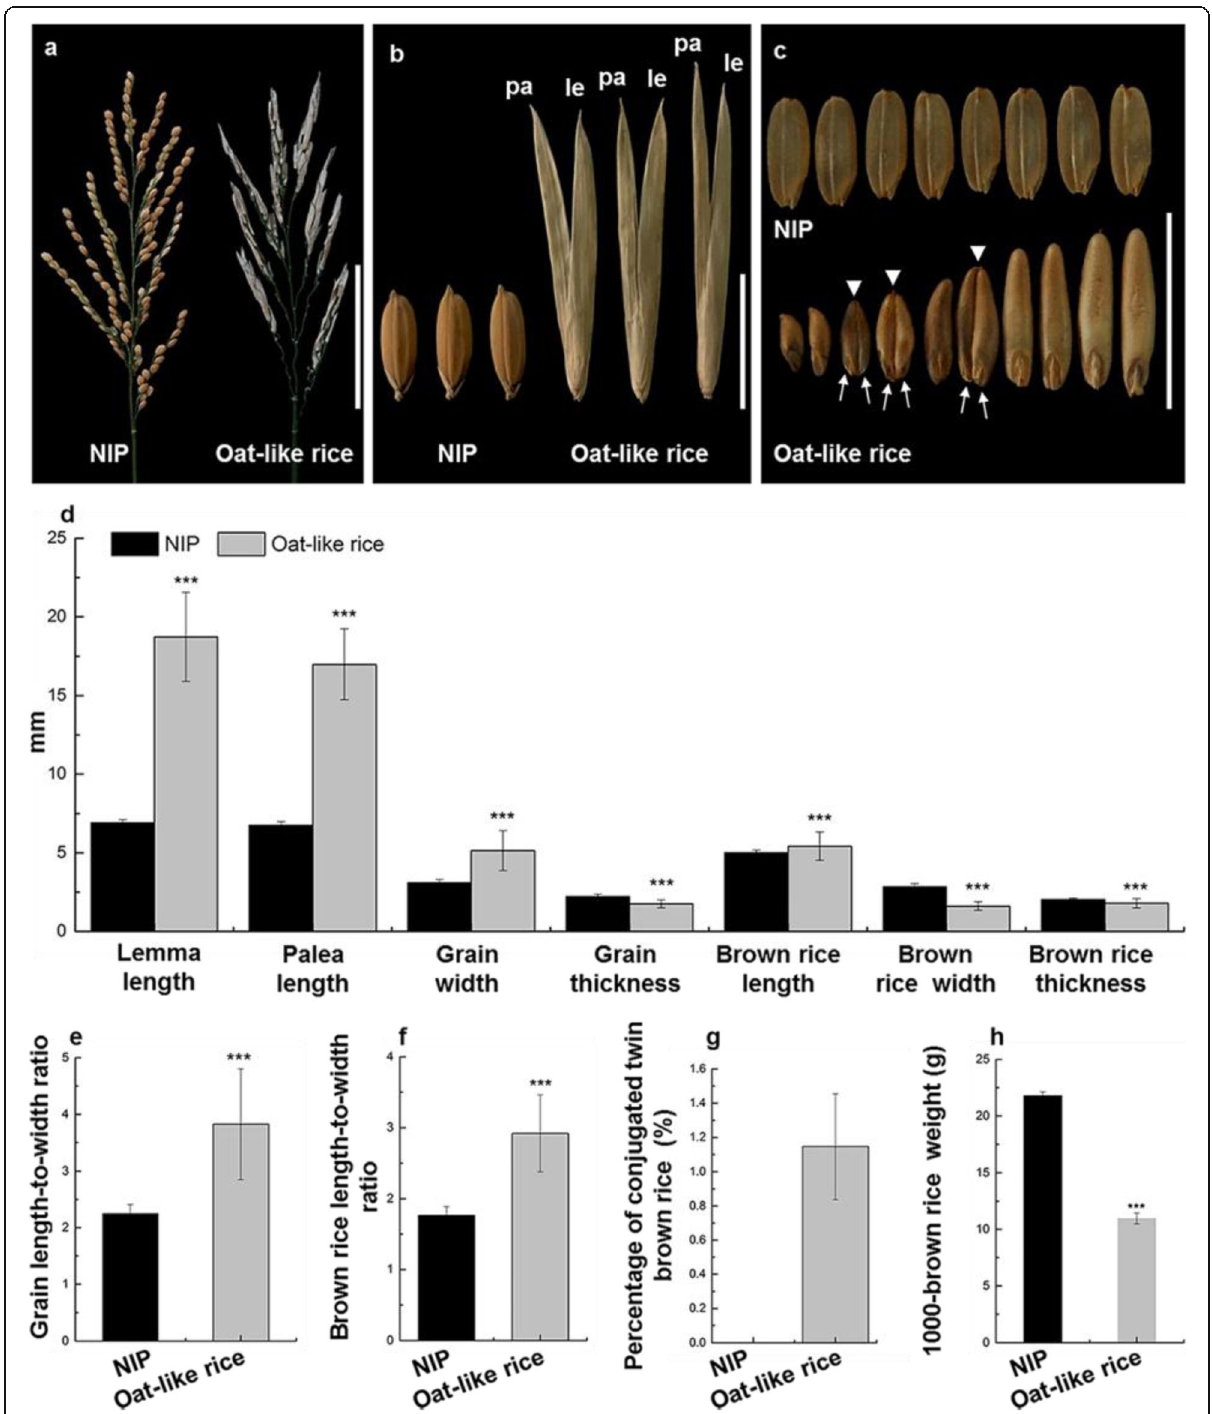
Fig. 1 Typical morphological characteristics of Oat-like rice . a Panicle morphology of NIP (left) and Oat-like rice (right). le, lemma; pa, palea. b Comparison of grain shape between NIP (left) and Oat-like rice (right). c Morphological comparison of brown rice between NIP (up) and Oat-like rice (down). Arrowheads indicate conjugated twin brown rice; arrows indicate two embryos of a conjugated twin brown rice grain. d Comparison of lemma length, palea length, grain width, grain thickness, brown rice length, brown rice width and brown rice thickness between NIP and Oat-like rice. e-h Comparison of grain length-to-width ratio ( e ), brown rice length-to-width ratio ( f ), percentage of conjugated twin brown rice ( g ) and 1000-brown rice weight ( h ), between NIP and Oat-like rice. Bars: ( a ) 10cm; ( b and c ) 1cm. Data presented are mean values± SDs [ n =140 in d - f ; n =3 replicates (1000-brown rice for each replicate) in g and h .]. Student ’ s t -test: *** p